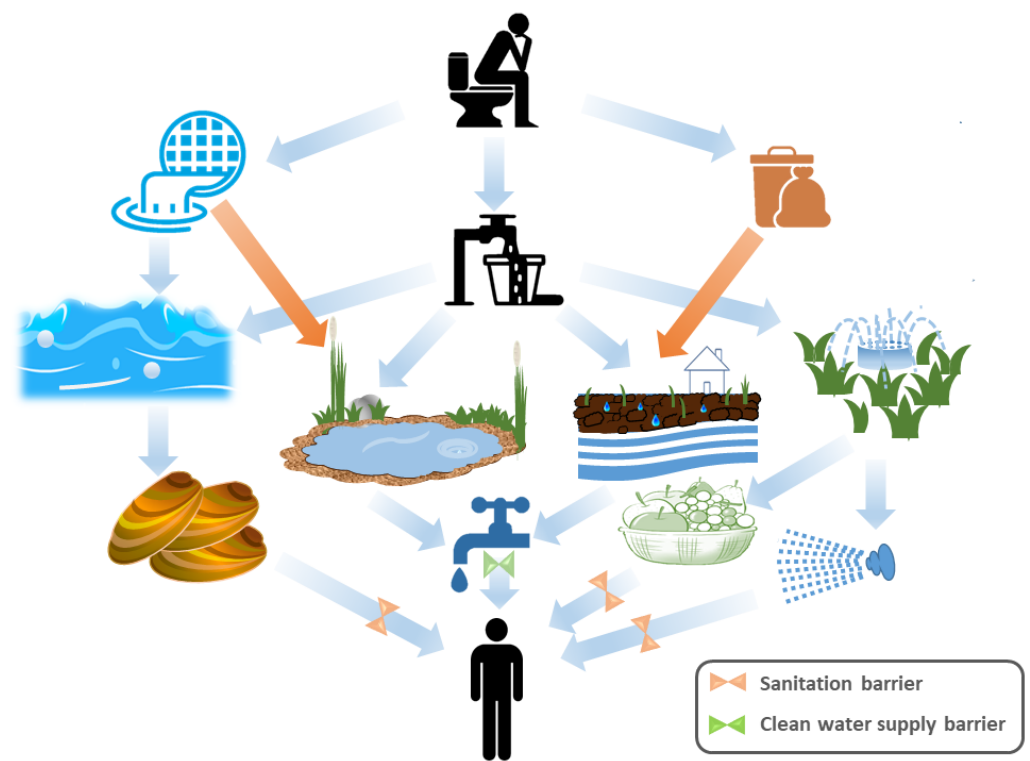
Figure 1. Diagrammatic representation of the fecal – oral route for transmission of enteric viruses. Human excreta go through land runoff and sewage that contaminate oceans, rivers, lakes and ground water. Moreover, sewage can contaminate irrigation water. The contaminated oceans, rivers and lakes influence filter feeders (shellfish) and recreation water, whereas the direct water supply would be affected by the improperly decontaminated ground water and rivers. Crops and irrigation-based aerosols are also contaminated by inadequately treated irrigation water. On the other hand, the human excreta give rise to solid wastes that affect the groundwater, leading to unclean water supply. Absence of a sanitation barrier and a properly clean water supply barrier lead to enteric virus infection of a new human host.